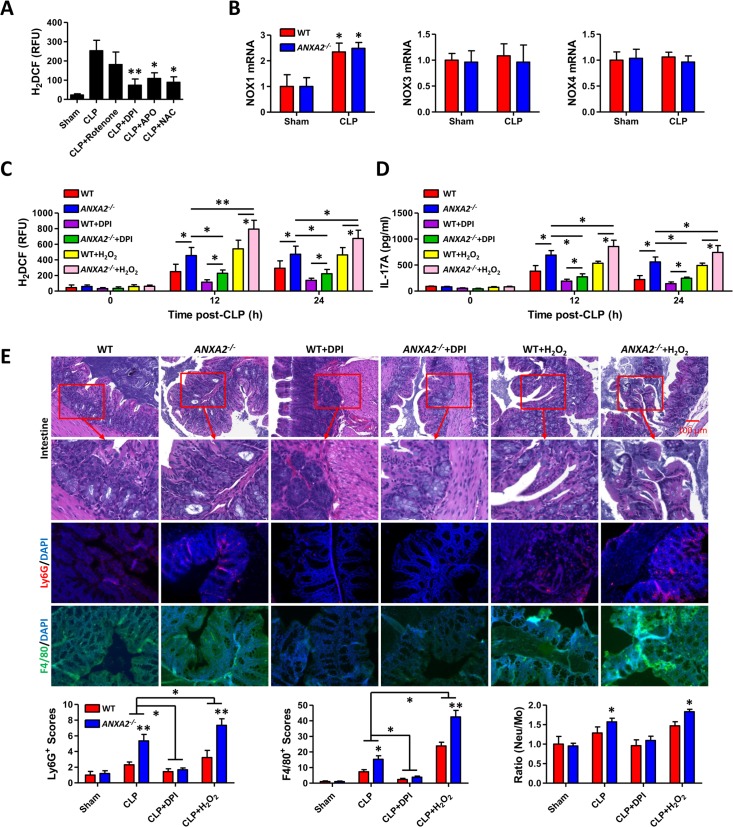
Increased ROS levels and inflammatory responses in anxa2
-/- mice with polymicrobial sepsis.(A) ROS levels were detected in PMs from anxa2
-/- mice pre-injected with rotenone, DPI, APO, and NAC, respectively. (B) PMs from WT and anxa2
-/- mice were subjected to qPCR to detect the NOX1, NOX3, and NOX4 expression. (C) Mice were pretreated with H2O2 or DPI and at 12 h or 24 h post-CLP, ROS levels in PMs were detected. (D) IL-17A in peritoneal lavage was assayed by ELISA. (E) At 24 h post-CLP, colon tissues were stained for histological analysis. Ly6G and IL-17A were used to detect immune cells recruitment and inflammatory cytokine secretion. Data are representative of three experiments and expressed as means+SD from triplicate. One-way ANOVA (Tukey’s post hoc); *, p<0.05; **, p<0.01. Scale bar = 5 μm.